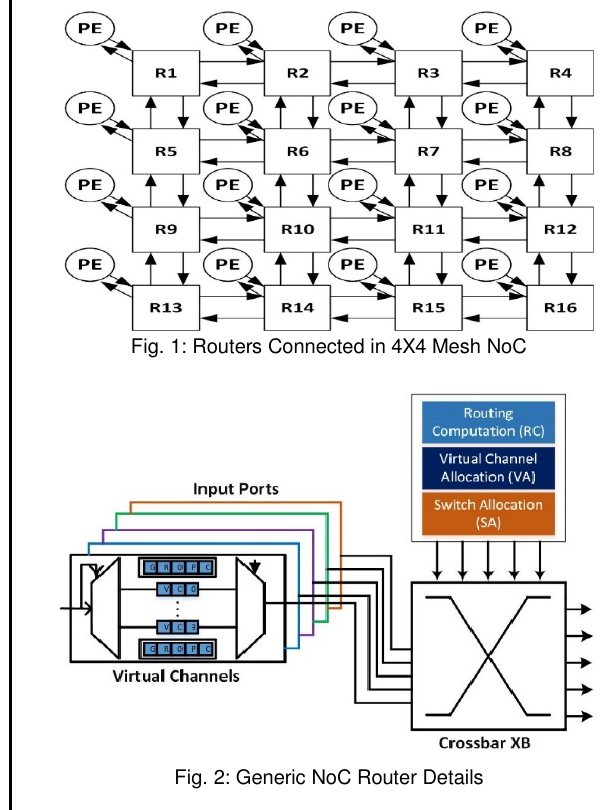
Fig. 2: Generic NoC Router